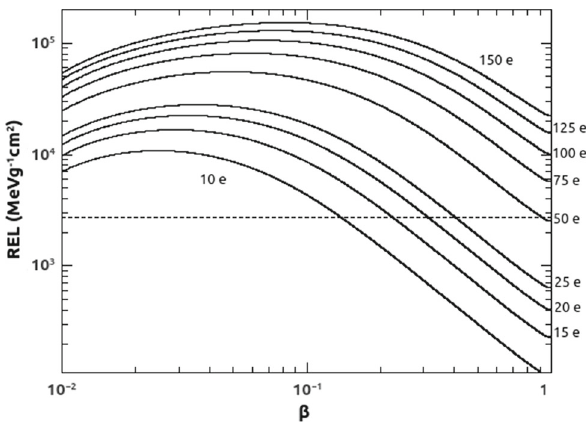
Fig. 4 RestrictedenergylossinMakrofol forHECOsofdifferentelec- tric charge. The horizontal dashed line indicates the Makrofol detection